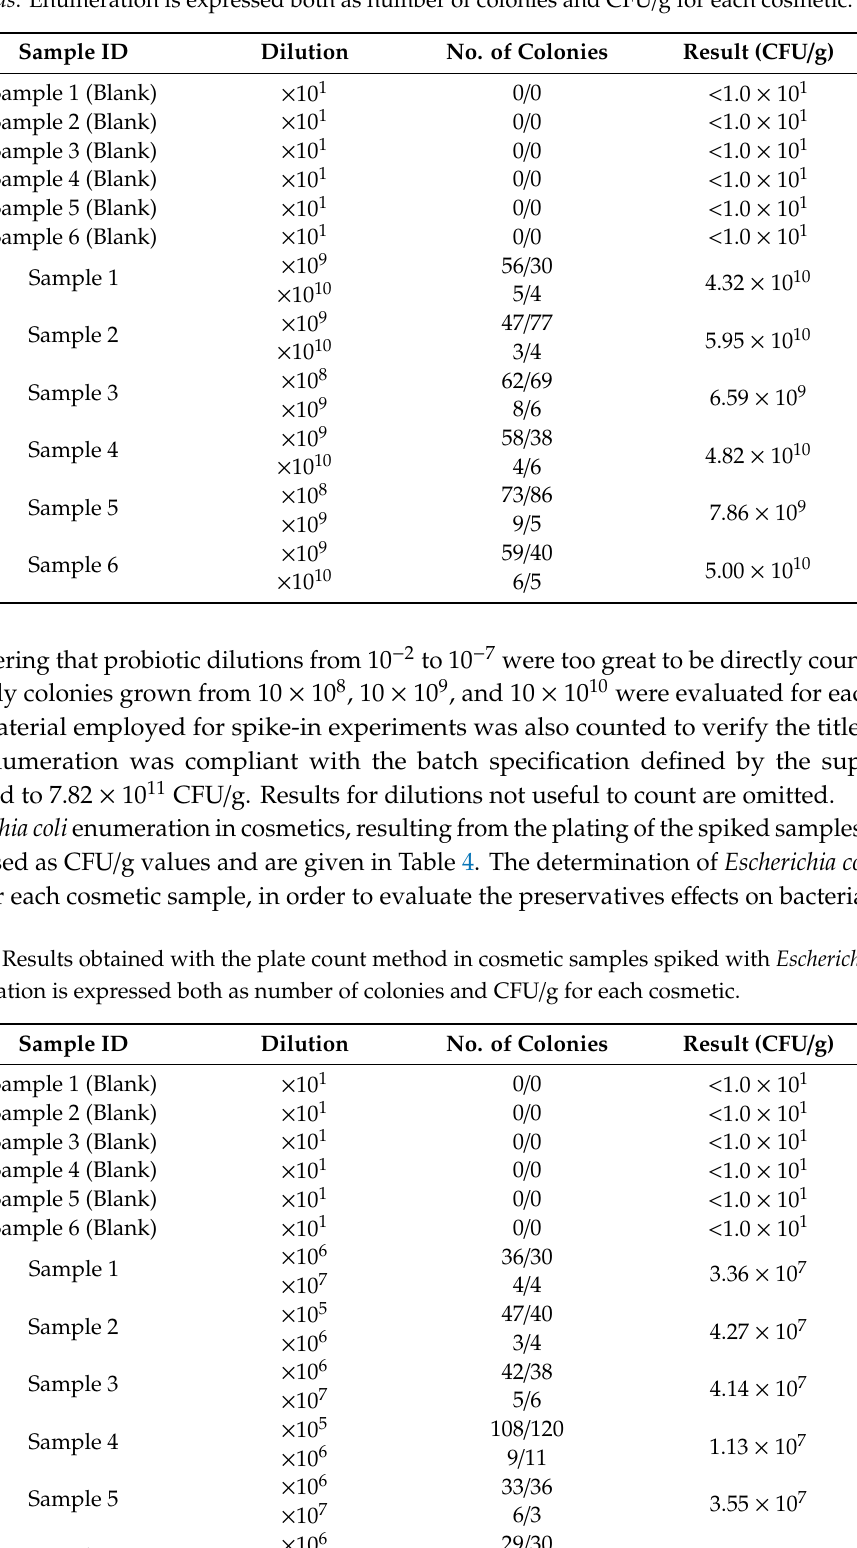
Table 3. Results obtained with the plate count method in cosmetic samples spiked with Lactobacillus rhamnosus . Enumeration is expressed both as number of colonies and CFU / g for each cosmetic.